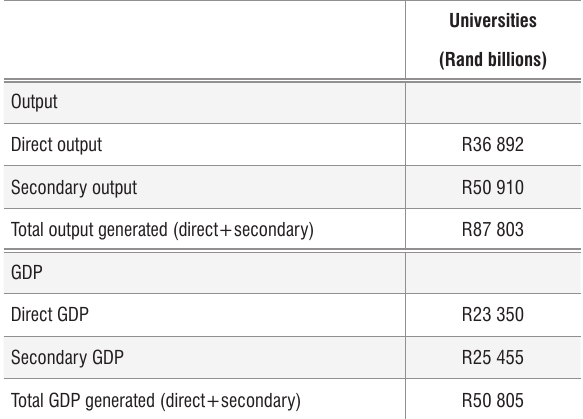
Impact of the higher education sector on South Africa’s